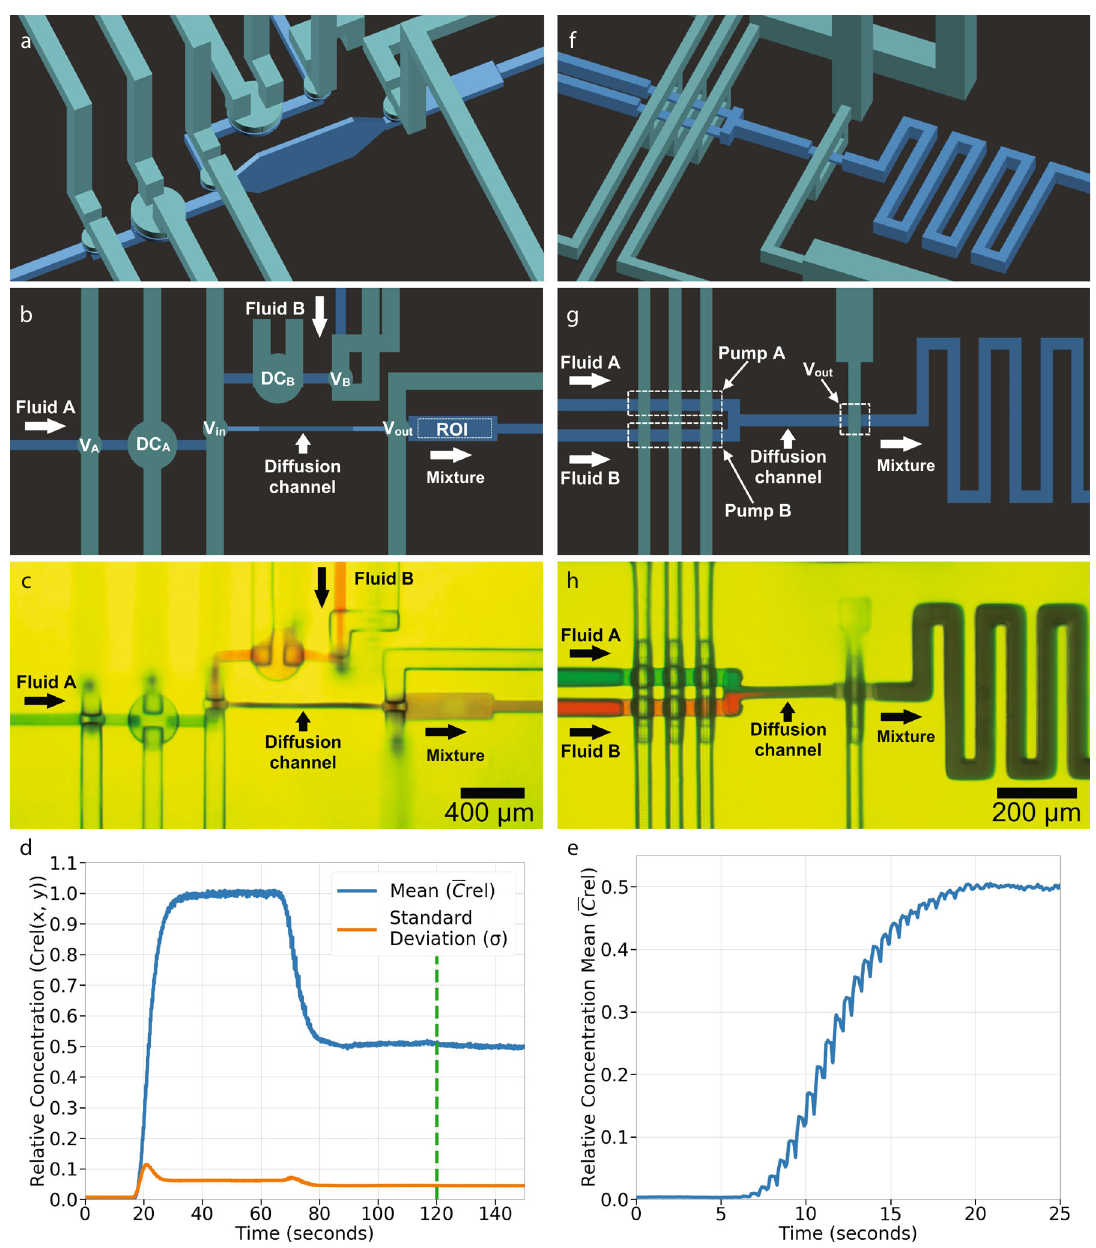
Fig. 5 Single stage 1:1 mixer. a – e Membrane valve-based pump version: schematic diagram ( a ) perspective view and ( b ) top view, ( c ) microscope photo, ( d ) mixing test, and ( e ) time to equilibrium test. Note in ( d ) that the mean, (cid:1) C rel , and standard deviation, σ , of the relative concentration are both plotted on the left vertical axis. f – h Squeeze valve-based pump version: schematic diagram ( f ) perspective view and ( g ) top view, ( h ) microscope